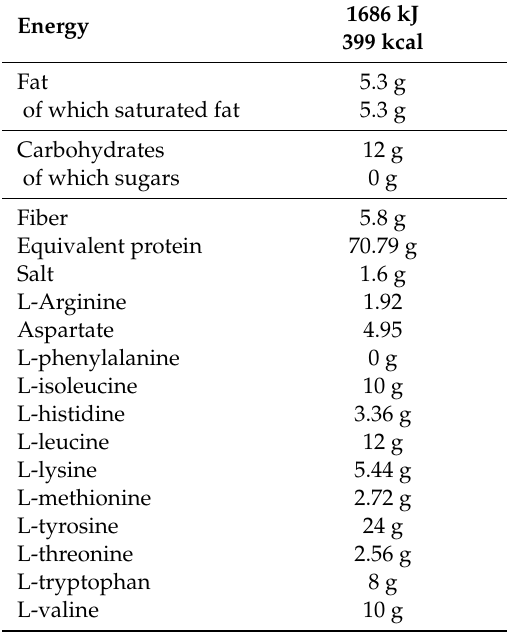
Table 1. Large neutral amino acids (LNAA): nutritional information per 100